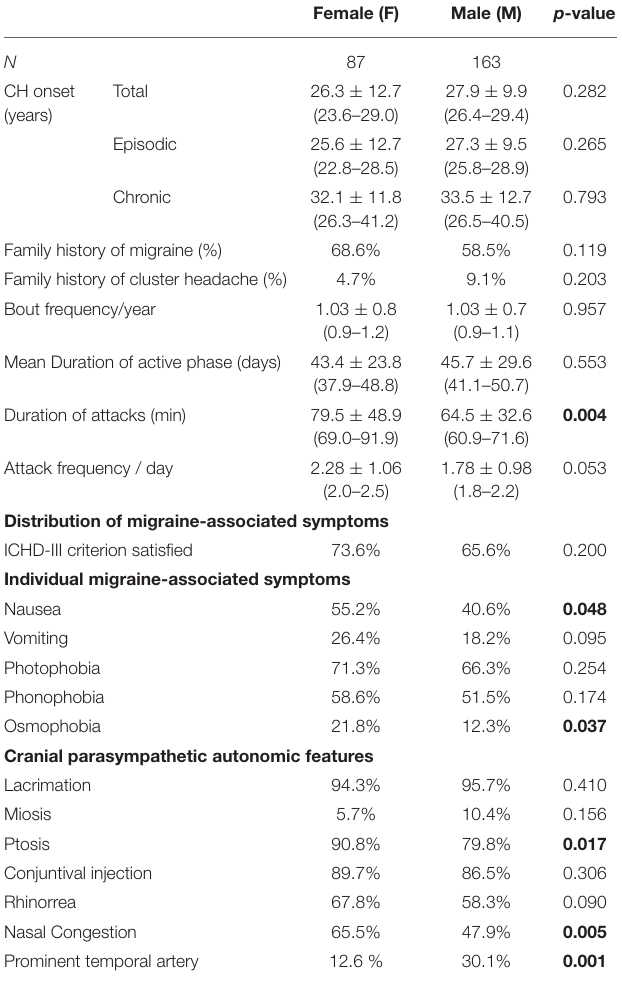
TABLE 2 | Clinical variables: comparison between sexes. Female (F) Male (M) p